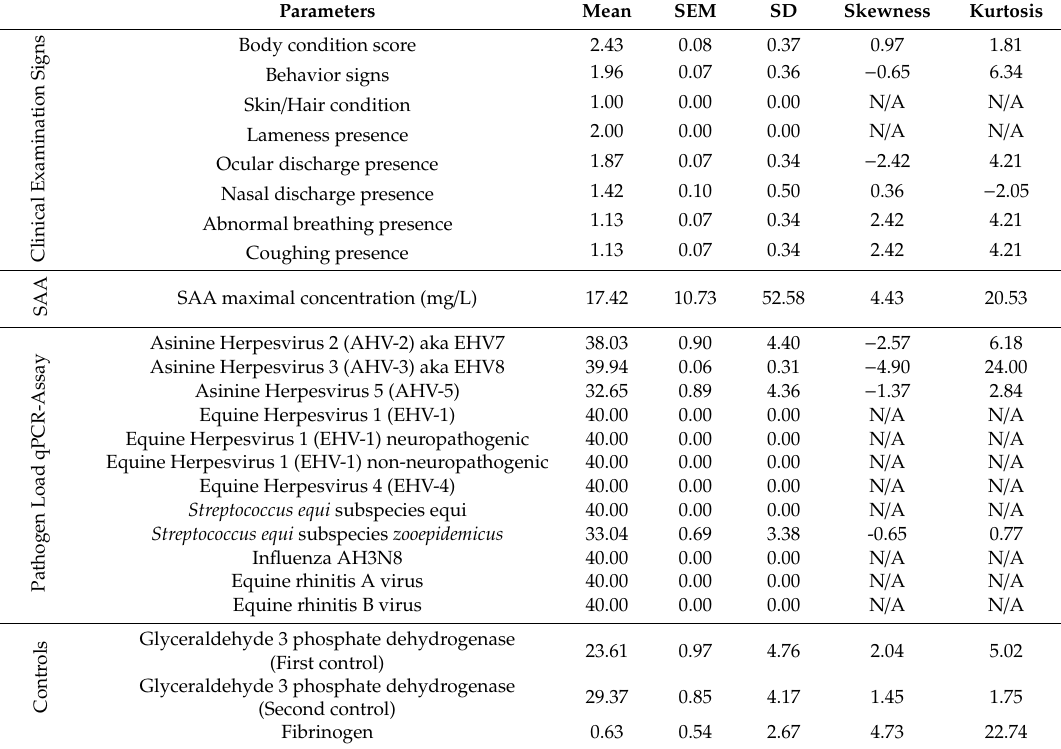
Table 3. Summary of descriptive statistics for clinical examination signs, SAA maximal concentration expressed in mg / L, qPCR-assay for organisms and controls at sampling moment two.